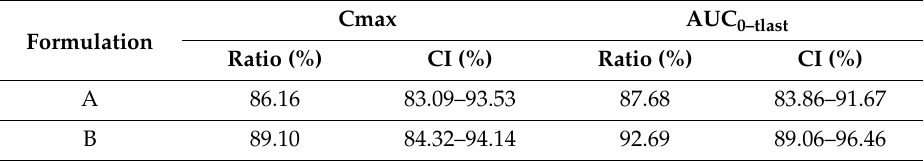
Table 1. In vivo bioequivalence results of the test